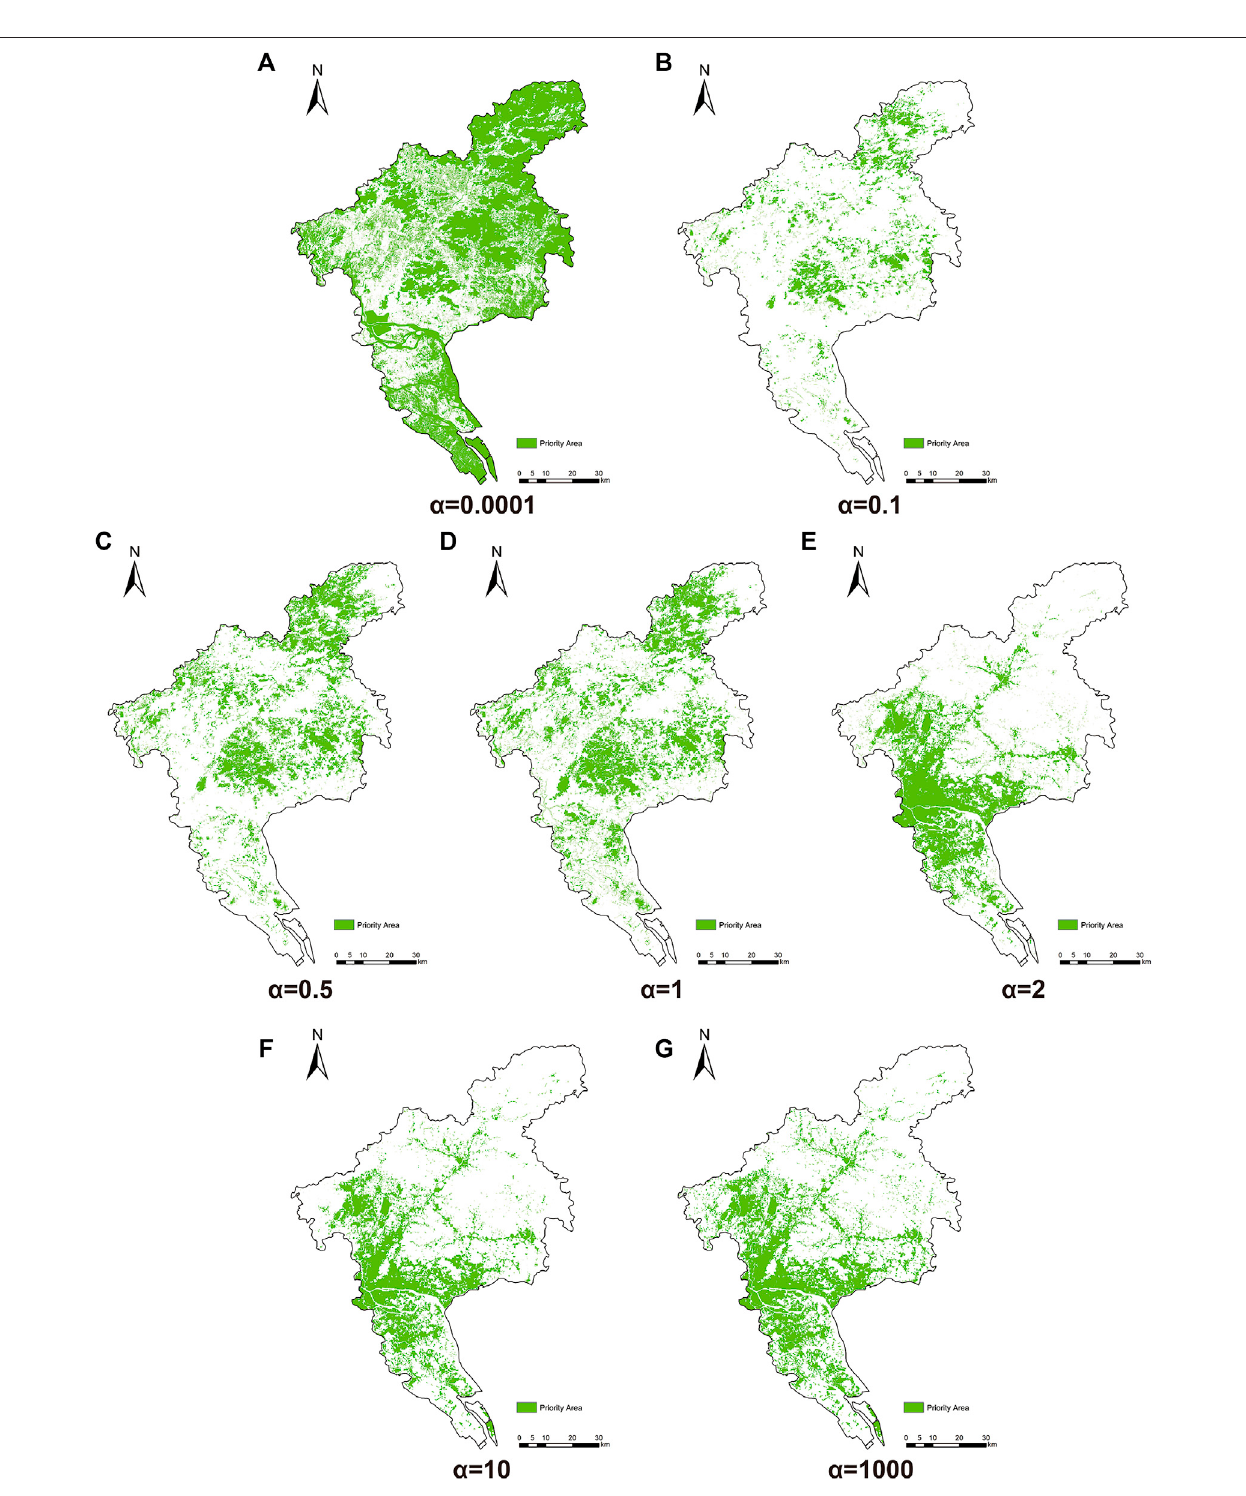
FIGURE 5 | Ecological priority area of different scenarios in